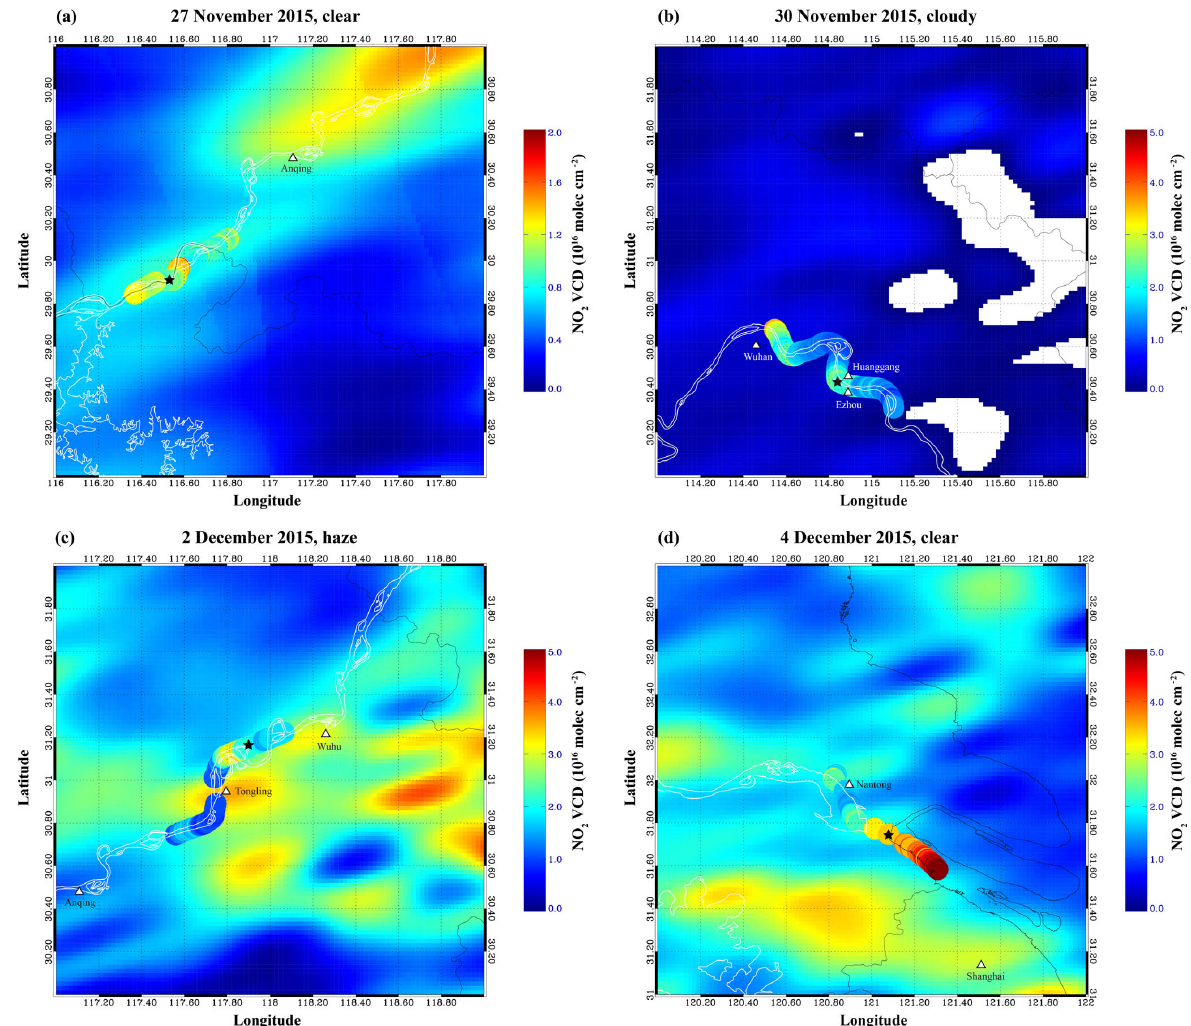
Figure 8. Spatial pattern of tropospheric NO 2 VCD measured by ship-based MAX-DOAS and OMI during four typical days within the Yangtze River campaign. The color-coded circle indicates the ship-based MAX-DOAS observations. Each plot shows examples of relatively clear (a, d) , cloudy (b) , and hazy (c) metrological conditions along the Yangtze River. The star symbols indicate the ship position during the OMI overpass time ( ∼ 13:45LT). The color bar scale of each panel is